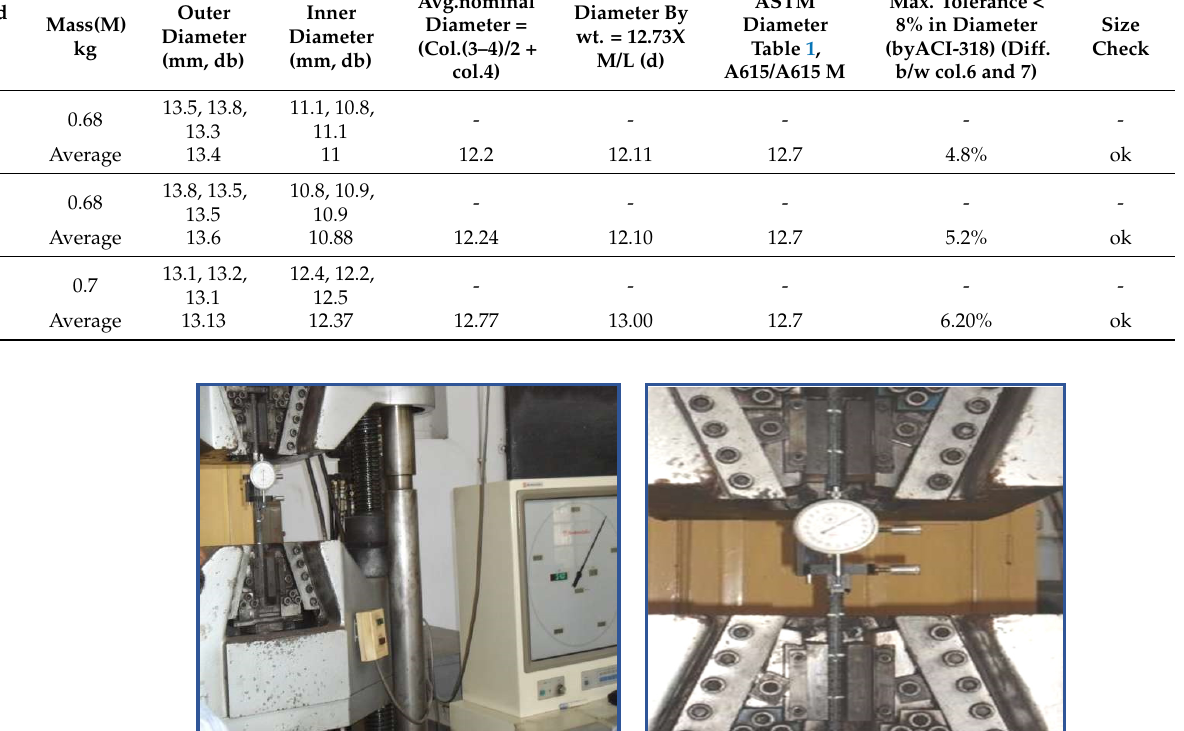
( d ) Figure 4. Casting–testing process: ( a ) Molds ready for casting; ( b ) Pullout samples after pouring; ( c ) Capped test samples after pouring; ( d ) Curing of test samples.